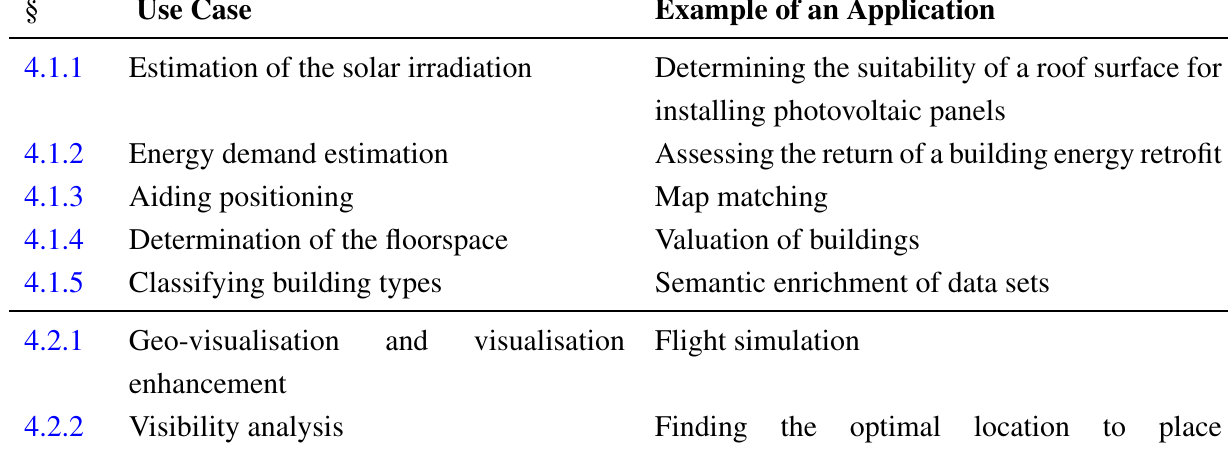
Table 1. Overview of the documented use cases of 3D city models, divided into two groups: non-visualisation and visualisation use